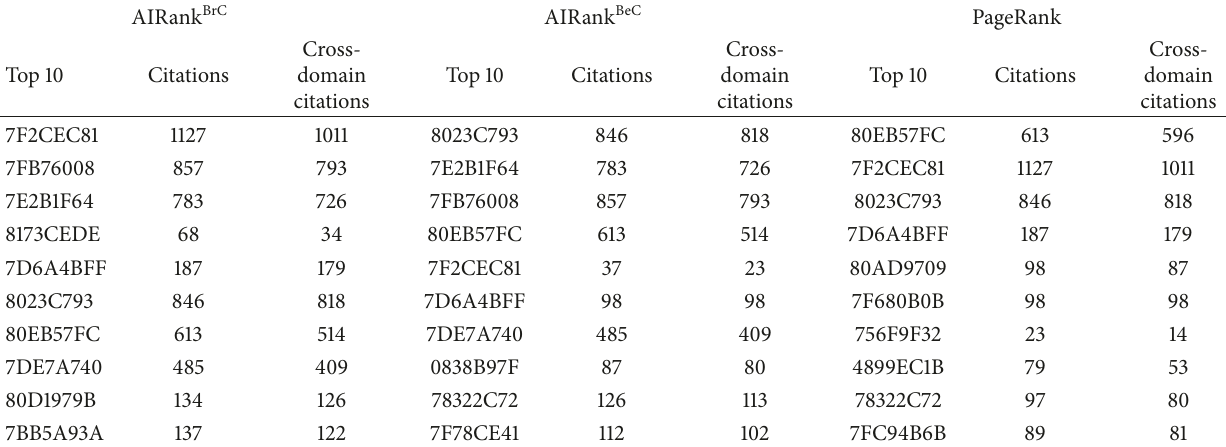
Table 1: Top 10 scholars of each method.